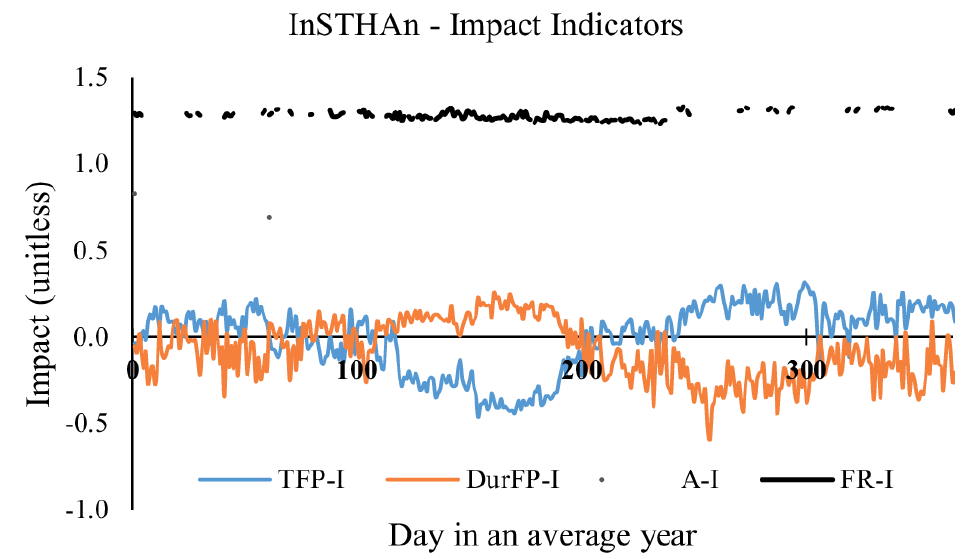
Figure 4. Outputs from the impact analyses ran in InSTHAn for the above mentioned characterization indicators (short-term impact indicators [STII]; -I denotes the impact on each indicator). Values around 0 mean a slight impact.